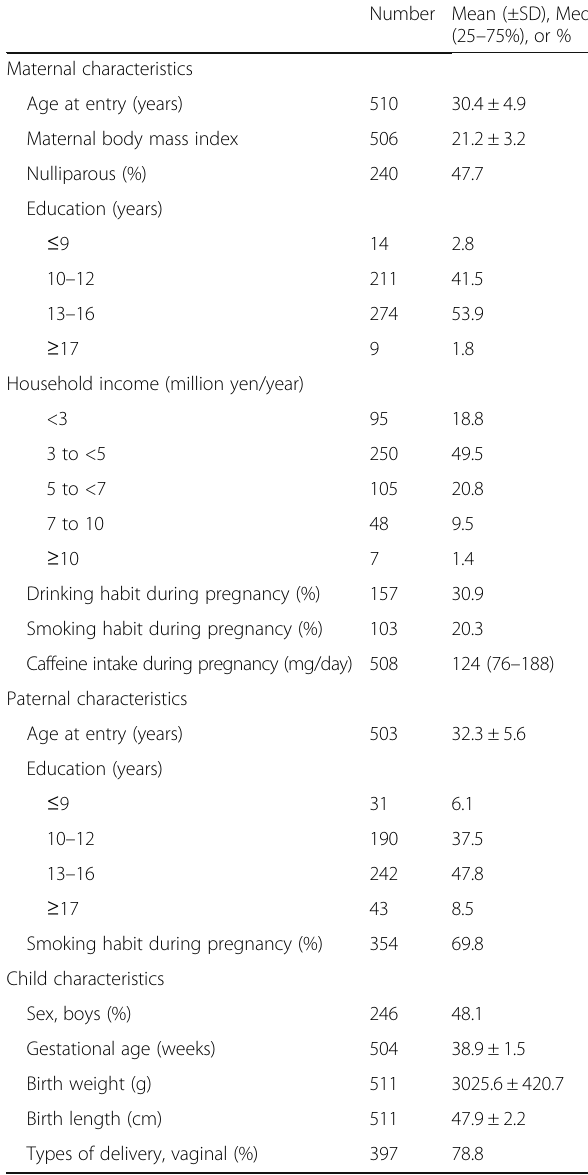
Number Mean (±SD), Med (25 – 75%), or %